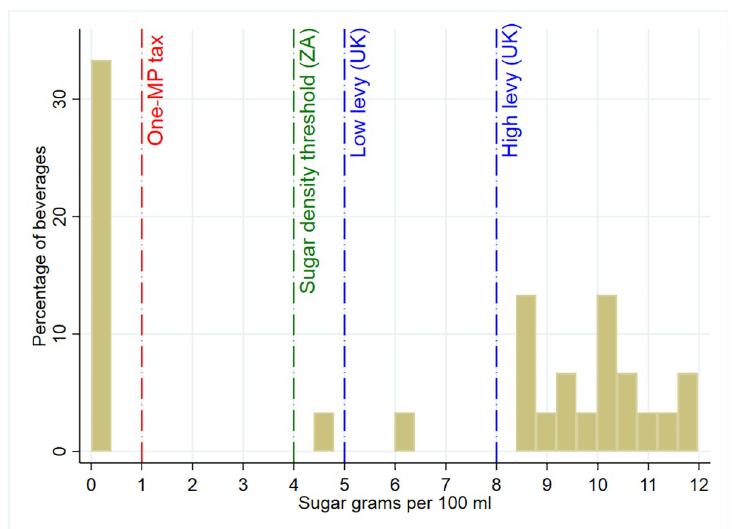
Fig 2. Sugar distribution across beverages in Mexico. MP: Mexican peso. UK: United Kingdom. ZA: South Africa. Source : Authors’ own analyses and calculations based on data from Nielsen through its Mexico Consumer Panel Service (CPS) for the food and beverage categories for January 2012 –December 2015. The Nielsen Company, 2016. Nielsen is not responsible for and had no role in preparing the results reported